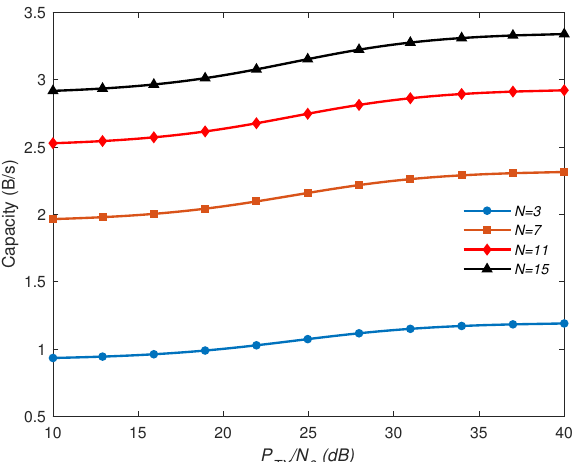
Figure 10. Information capacity of OAM channels versus the ratio of noise to system power P TX / N 0 and channel number N